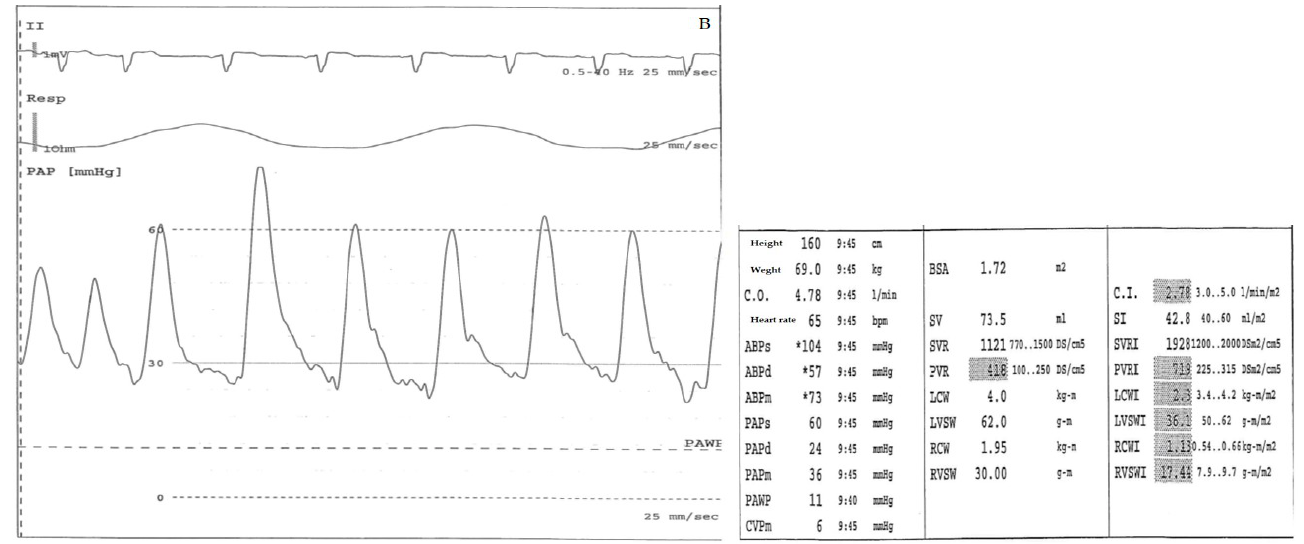
Figure 2. ( A ) Right cardiac catheterization in a CTEPH patient, not a candidate for surgical treatment due to the involvement of the distal pulmonary arteries (technically inaccessible), before treatment (as reported in the table at right PVR 480 dynes/sec/cm (-5)), * software evaluation. From below: pulmonary arterial pressure, respiratory, and ECG waveforms during arterial catheterization. The first part of the pressure trace reflects the pressure in a pulmonary artery (large swings, dicrotic notch). Then, the balloon is inflated, and the tip of the Swan Ganz catheter floats until it wedges in a small artery (small swings synchronous with respiratory rate). This provides a pulmonary arterial wedge pressure (PAWP), i.e., an indirect measure of the pressure in the left ventricle. ( B ) Right cardiac catheterization in the same patient after three months of treatment with riociguat as per data sheet (as reported in the table at right PVR 418 dynes/sec/cm (-5)).